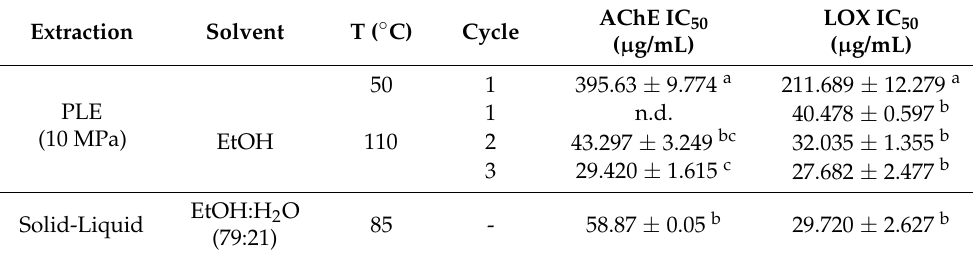
Table 5. AChE and LOX IC 50 values for d-PFBP